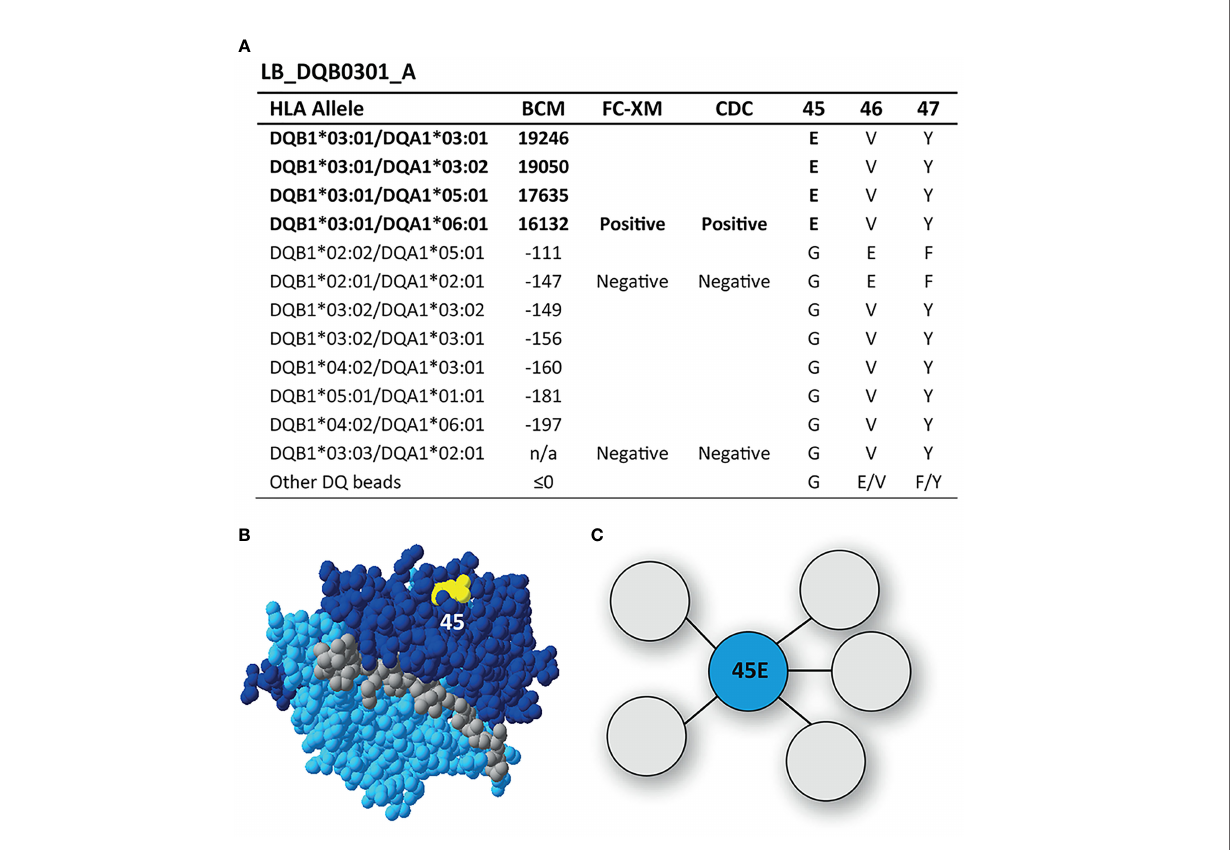
FIGURE 2 | Reactivity analysis of monoclonal antibody LB_DQB0301_A. (A) Comparison of the amino acid positions of interest of the HLA-DQB1 alleles on the reactive beads in the single antigen bead assay and a selection of the nonreactive HLA-DQB1 alleles. (B) Location of amino acid 45E (yellow) is indicated on the crystal structure of DQB1*03:02/DQA1*03:01 (PBD: 4Z7U). The b chain is depicted in dark blue, the a chain in light blue, and the peptide in grey. (C) Schematic representation of the antibody-footprint of LB_DQB0301_A interacting with the functional epitope 45E (cyan). BCM, background corrected mean fl uorescence intensity; FC-XM, fl owcytometric crossmatch; CDC, complement dependent cytotoxicity; PBD, Protein Data